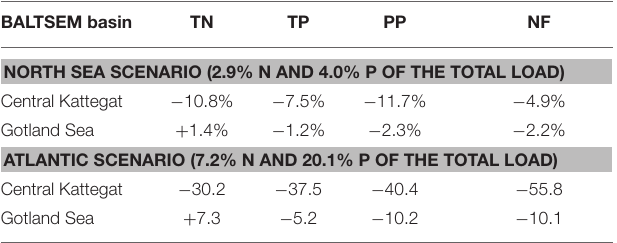
TABLE 6 | Relative changes (in %) of the average (2050–2300) of annual mean nutrient concentrations and integral fluxes induced by the “North Sea” and “Atlantic” scenario reductions of the nitrogen and phosphorus imports from